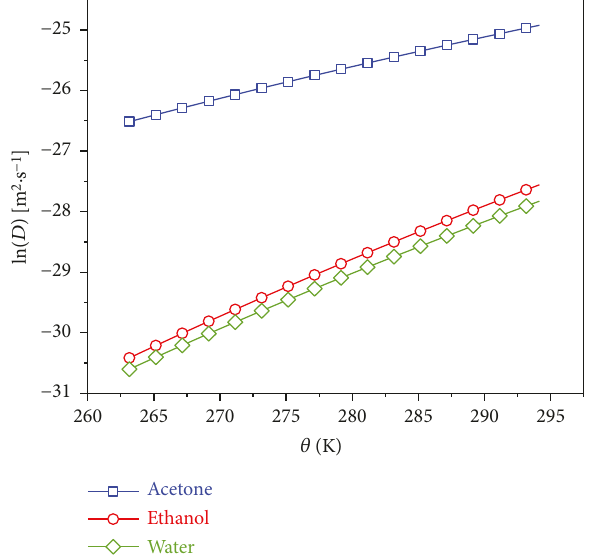
Figure 7: The temperature dependency of di ff usion coe ffi cients of three di ff erent solvents (acetone, ethanol, and water) inside Estane to demonstrate the dependence of ln D versus θ for the sorption process. The data are obtained from experimental weight gain measurements.